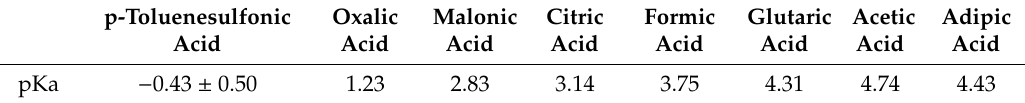
Figure 4. Digital image of PBI-1 aggregates assembled in various organic acids corresponding to different r values, from 0:1 to 10,000:1. ( a ) p-Toluenesulfonic acid, ( b ) oxalic acid, ( c ) malonic acid, ( d ) citric acid, ( e ) formic acid, ( f ) glutaric acid and ( g ) acetic acid. Table 1. pKa values of several organic acids.